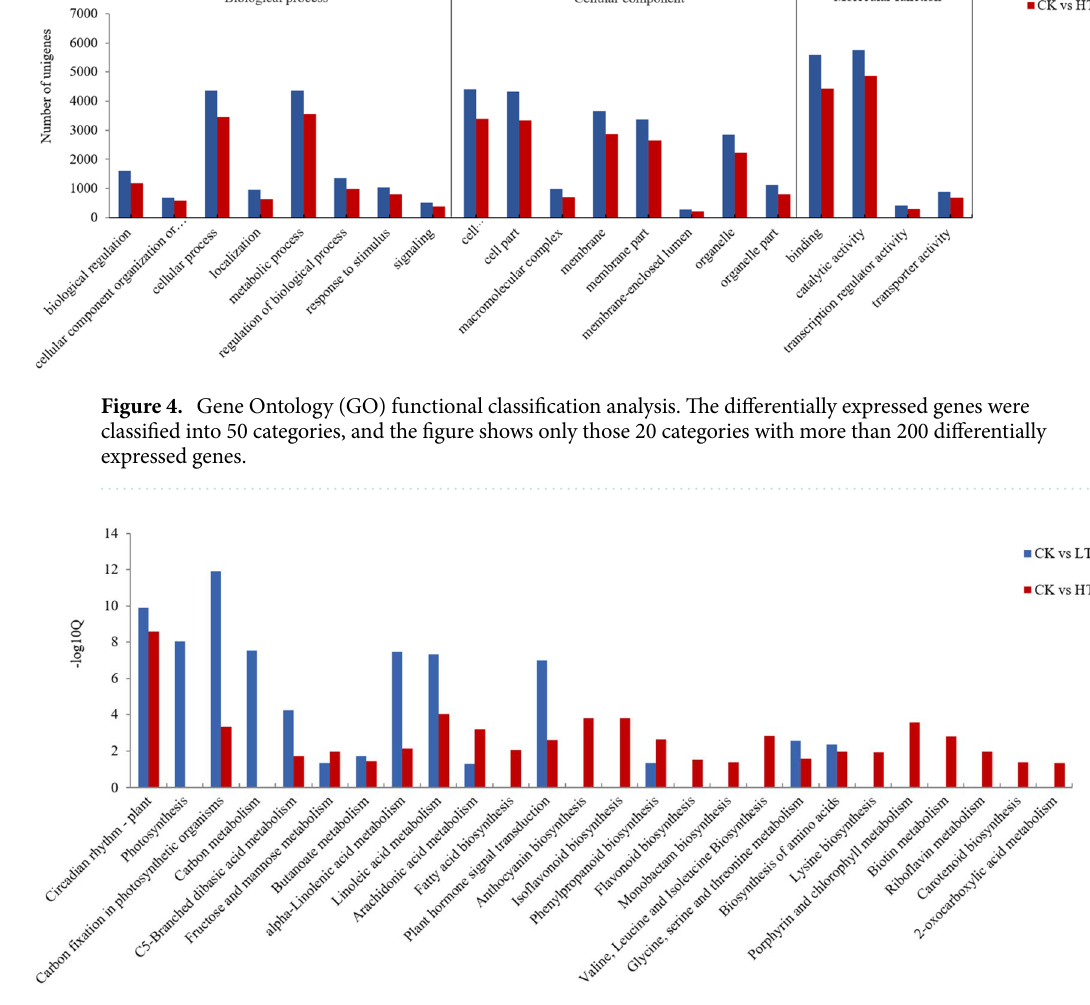
Figure 5. KEGG pathway enrichment map (Q value < 0.05). The Q value is obtained after P value correction, and Q value < 0.05 indicates